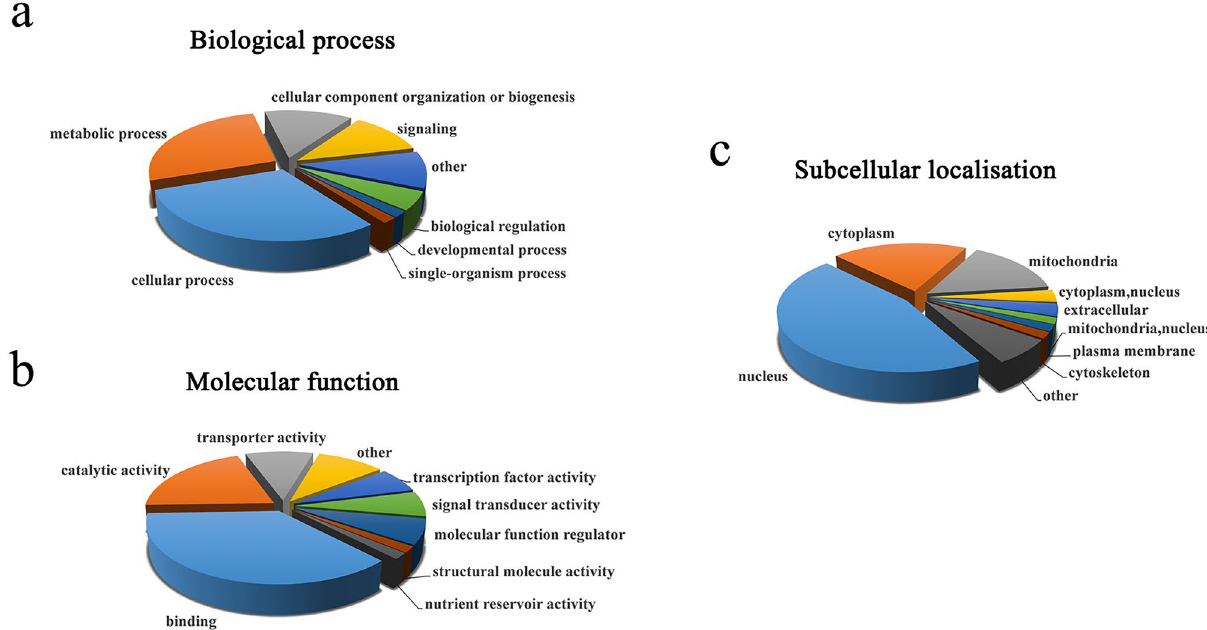
Figure 4. Gene Ontology functional classification of Crmapk-interacting proteins in C. chloroleuca 67-1. ( a ) Classification of interacting proteins based on biological process. ( b ) Classification of interacting proteins based on molecular function. ( c ) Subcellular localisation of interacting proteins. Blast2GO and WoLF SPORT Software were used for GO functional classification